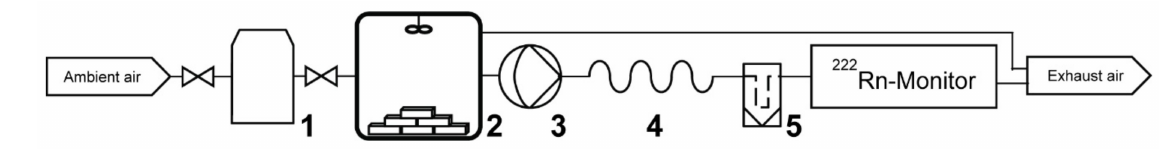
Figure 3. Sampling procedure with thoron delay line: ( 1 ) air supply system, ( 2 ) loaded emission test chamber, ( 3 ) sampling pump, ( 4 ) delay line, ( 5 ) radon progeny filter